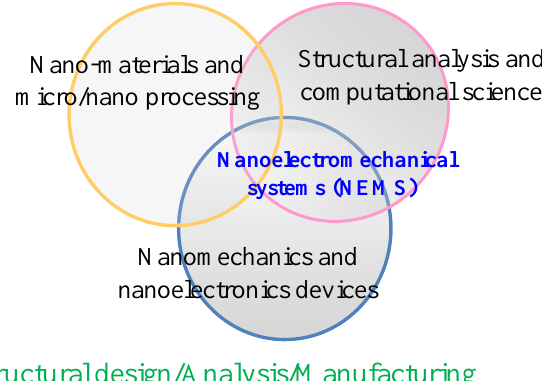
Figure 1. Components of nanoelectromechanical system.